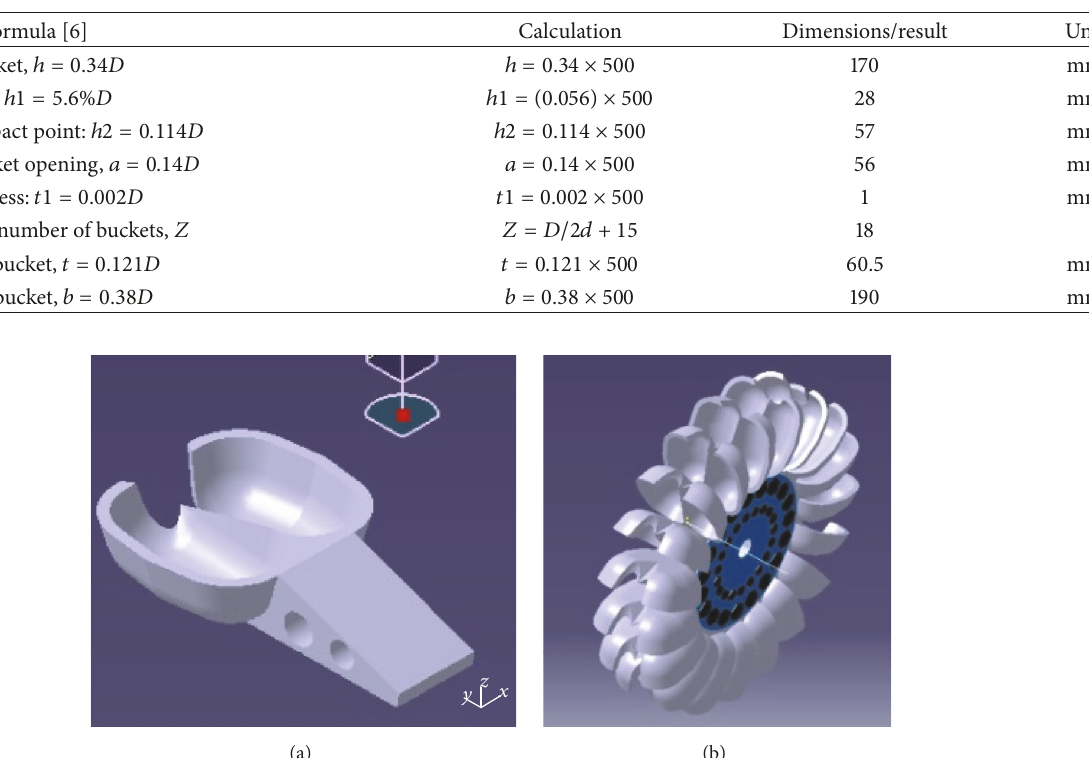
Table 6: Physical baseline bucket dimensions result for the selected site data.